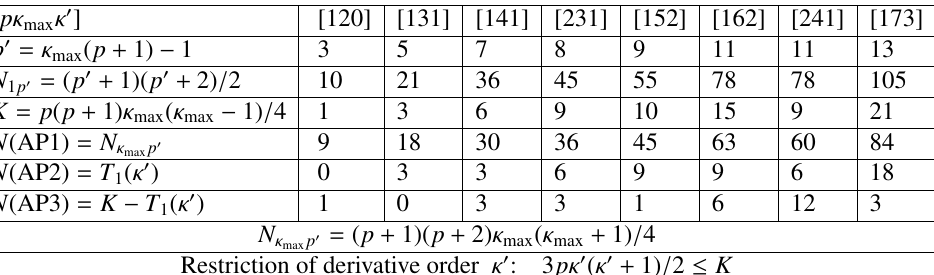
Table 1. Characteristics of the HIP bases